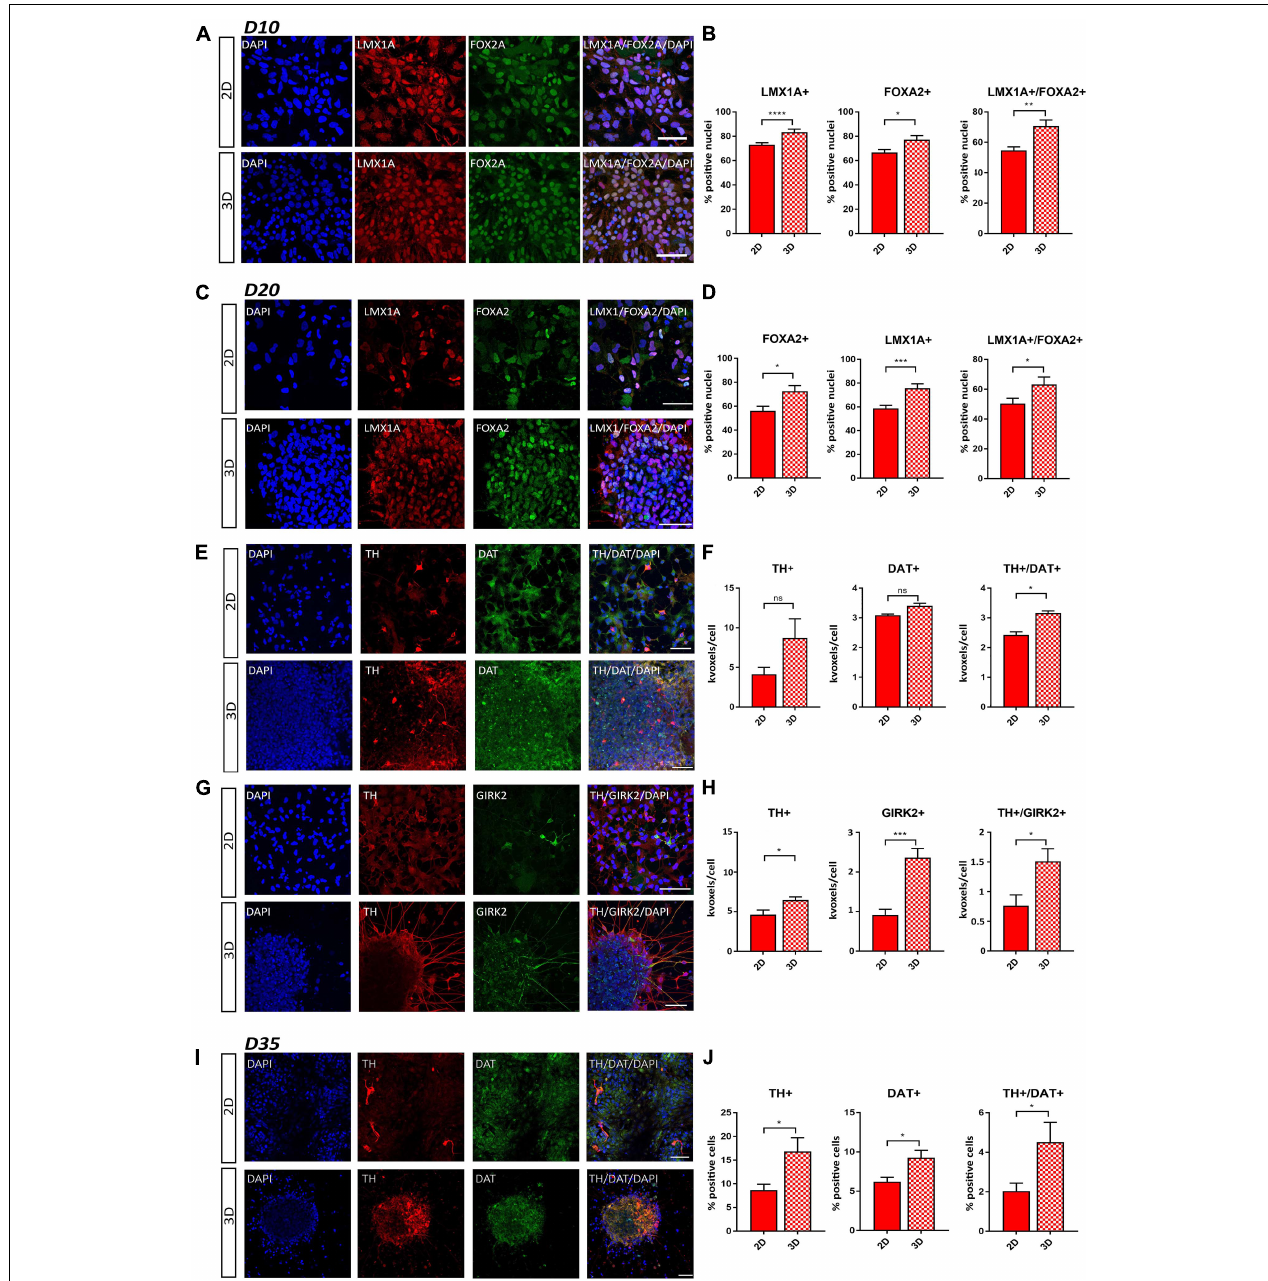
FIGURE 3 | Comparative immunofluorescence analysis of early DA neuron markers. (A) Representative staining of LMX1A + and FOXA2 + cells at day 10 of differentiation. (B) Percentage of LMX1A + , FOXA2 + , and LMX1A + /FOXA2 + double positive cells at day 10 of differentiation. (C) Representative staining of LMX1A + and FOXA2 + cells at day 20 of differentiation. (D) Percentage of LMX1A + , FOXA2 + , and LMX1A + /FOXA2 + double positive cells at day 20 of differentiation. (E) Representative staining of TH + and DAT + cells at day 20 of differentiation. (F) Quantification of TH + , DAT + , and TH + /DAT + double positive cells at day 20 of differentiation by using positive volume (thousands of voxels, kvoxels) divided by the number of nuclei. (G) Representative staining of TH + and GIRK2 + cells at day 20 of differentiation (for this combination, another TH-antibody was used as in E ). (H) Quantification of TH + , GIRK2 + , and TH + /GIRK2 + double positive cells at day 20 of differentiation by using positive volume (thousands of voxels, kvoxels) divided by the number of nuclei. (I) Representative staining of TH + and DAT + cells at day 35 of differentiation. (J) Quantification of TH + , DAT + , and TH + /DAT + double positive cells at day 35 of differentiation by counting the number of positive cells, which were clearly identifiable at this stage. Scale bars represent 50 µ m. Statistical differences were calculated by a paired two-tailed t -test * p ≤ 0.05, ** p ≤ 0.01, *** p ≤ 0.001, **** p ≤ 0.0001.